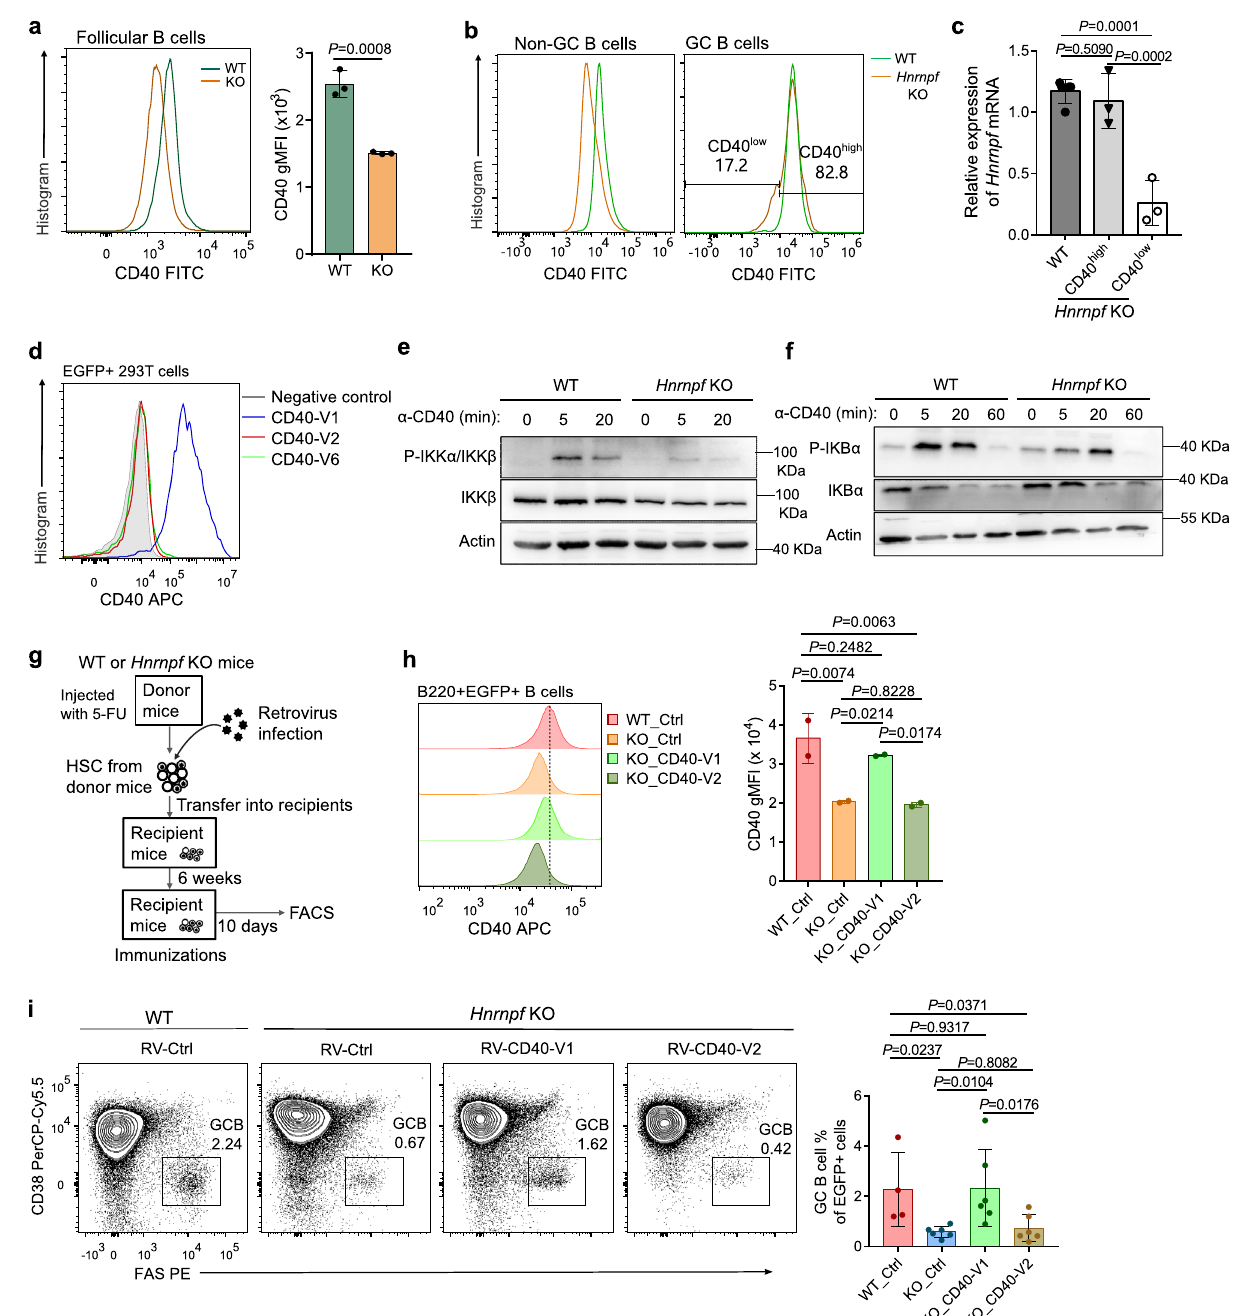
Fig. 6 | hnRNP F regulates GC B cell formation by promoting signalling- competent CD40 expression. a Flow cytometric analysis of the cell surface expression of CD40 on WT and Hnrnpf KO FOB cells ( n =3 per group). b Flow cytometricanalysisofthecellsurfaceexpressionofCD40onWTand Hnrnpf KOGC (B220 + CD38 - FAS + ) and non-GC (B220 + CD38 + FAS - ) B cells. c Knockout ef fi ciency of hnRNPFin Hnrnpf KOGCBcellswithhighandlowCD40expressionusingqRT-PCR ( n =4 for WT group and n =3 for Hnrnpf KO group). d Flow cytometry analysis of the cell surface expression of CD40 on 293T cells transfected with different CD40 variants. e , f Immunoblotting of phosphorylation of IKK α /IKK β ( e ) and I κ B α ( f ) in WT and Hnrnpf KO splenic B cells stimulated by 1 μ g/ml anti-CD40 antibody. Data are from one single experiment ( e and f ). g The experimental fl ow of mixed BM